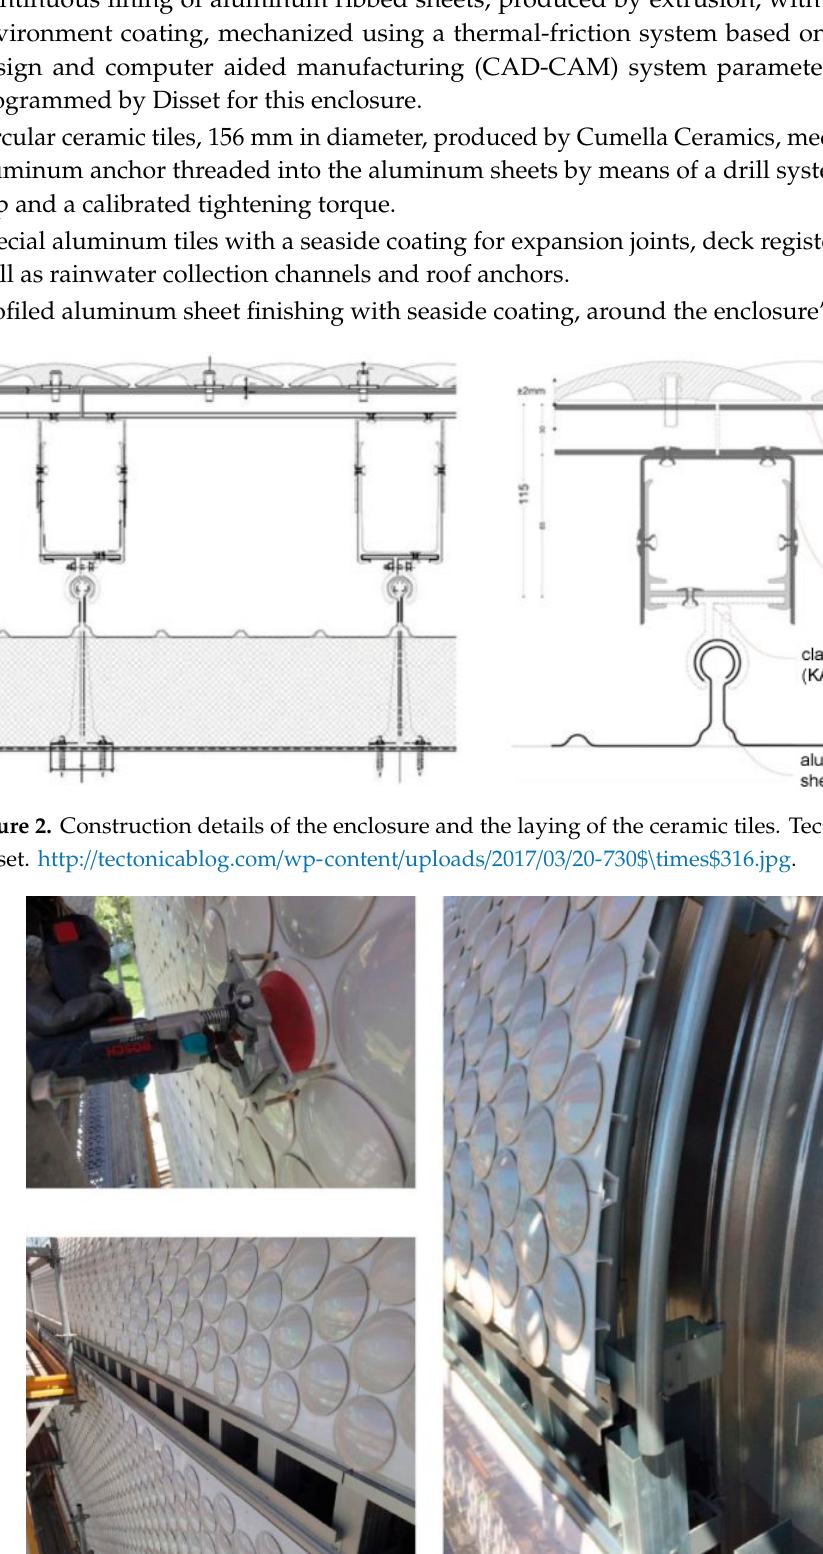
Figure 4. View from the roof. Chromatic integration with the sea. Photograph: Fernando Echarri.